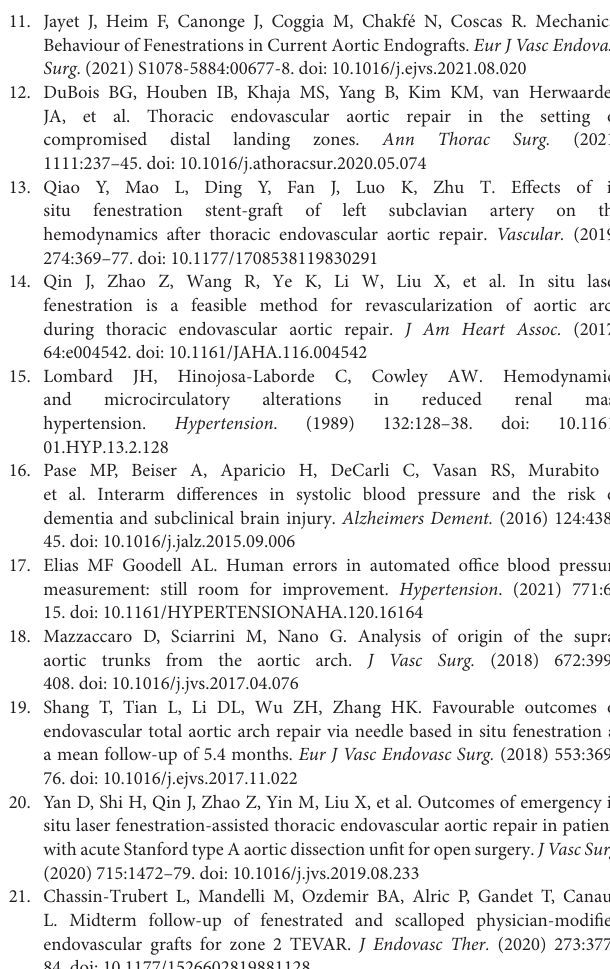
Supplementary Figure S1 | Schematic diagram of different fenestration positions of LSA branch stent: P0: not affected by the metal structure of the main endograft; P1: affected by one metal structure of the main endograft; P2: Affected by two metal structures of the main endograft. Supplementary Figure S2 | Postoperative three-dimensional (3D) computed tomography angiography reconstruction image showed different fenestration positions of LSA branch stents. (A) LSA branch stent was not affected by metal structure (P0). (B) LSA branch stent was affected by one metal structure (P1). (C) LSA branch stent was affected by two metal structures